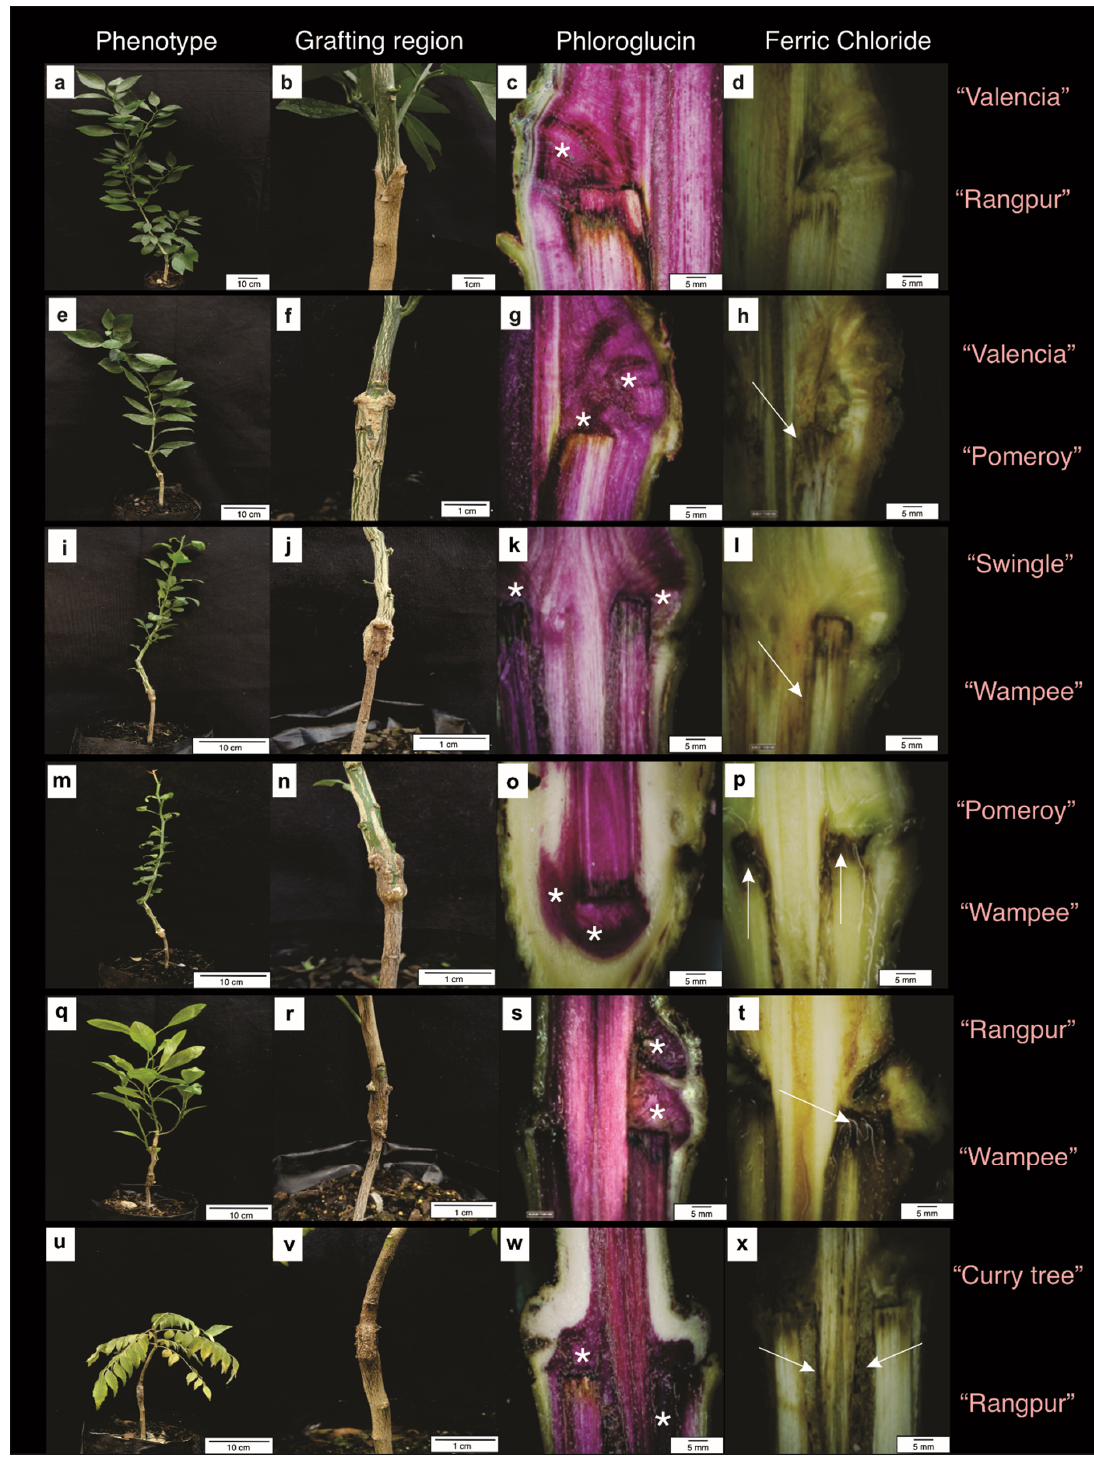
Figure 1. Six grafting combinations of Aurantioideae plants indicating the plant phenotype ( a , e , i , m , q , u ) and images of the graft union ( b , f , j , n , r , v ), phloroglucin reaction ( c , g , k , o , s , w ), and ferric chloride ( d , h , l , p , t , x ). Asterisks in ( c , g , k , o , s , w ): phloroglucin reaction in pink indicates lignified cell walls. Arrows in ( h , l , p , t , x ): ferric chloride indicates phenolic compounds in brown. Valen- cia/Rangpur does not indicate phenolic compounds in the grafted region. Strong reactions were ob- served in Rangpur/Wampee in the grafted region (arrows).